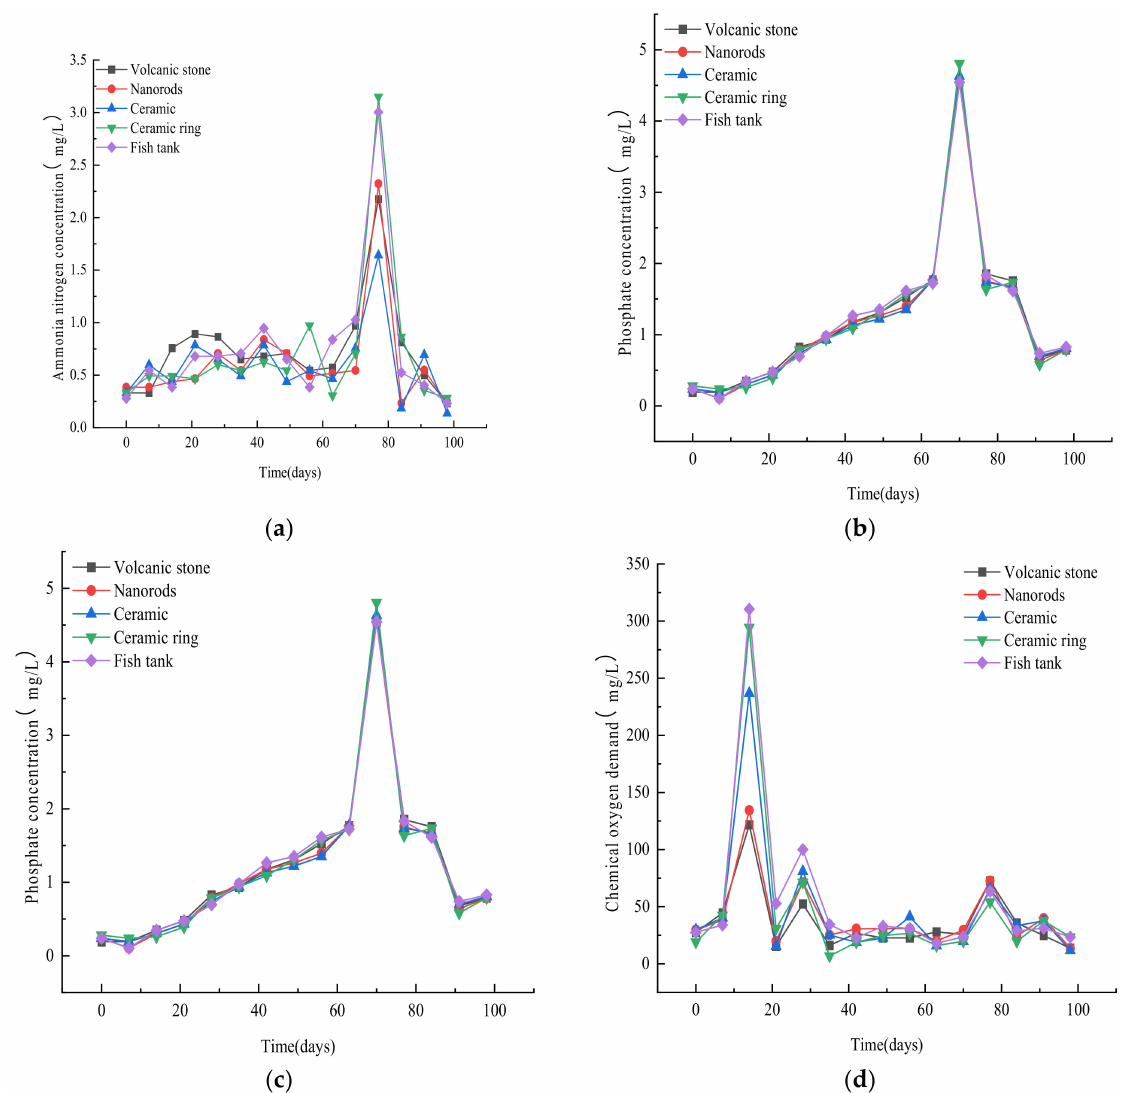
Figure 5. Changes in ammonia nitrogen ( a ), phosphate ( b ), nitrate-nitrogen ( c ), and chemical oxygen demand ( d ) concentrations in each filter tank and the fish tank after plants were added to the aquaponics system. Day 0 was 23 April